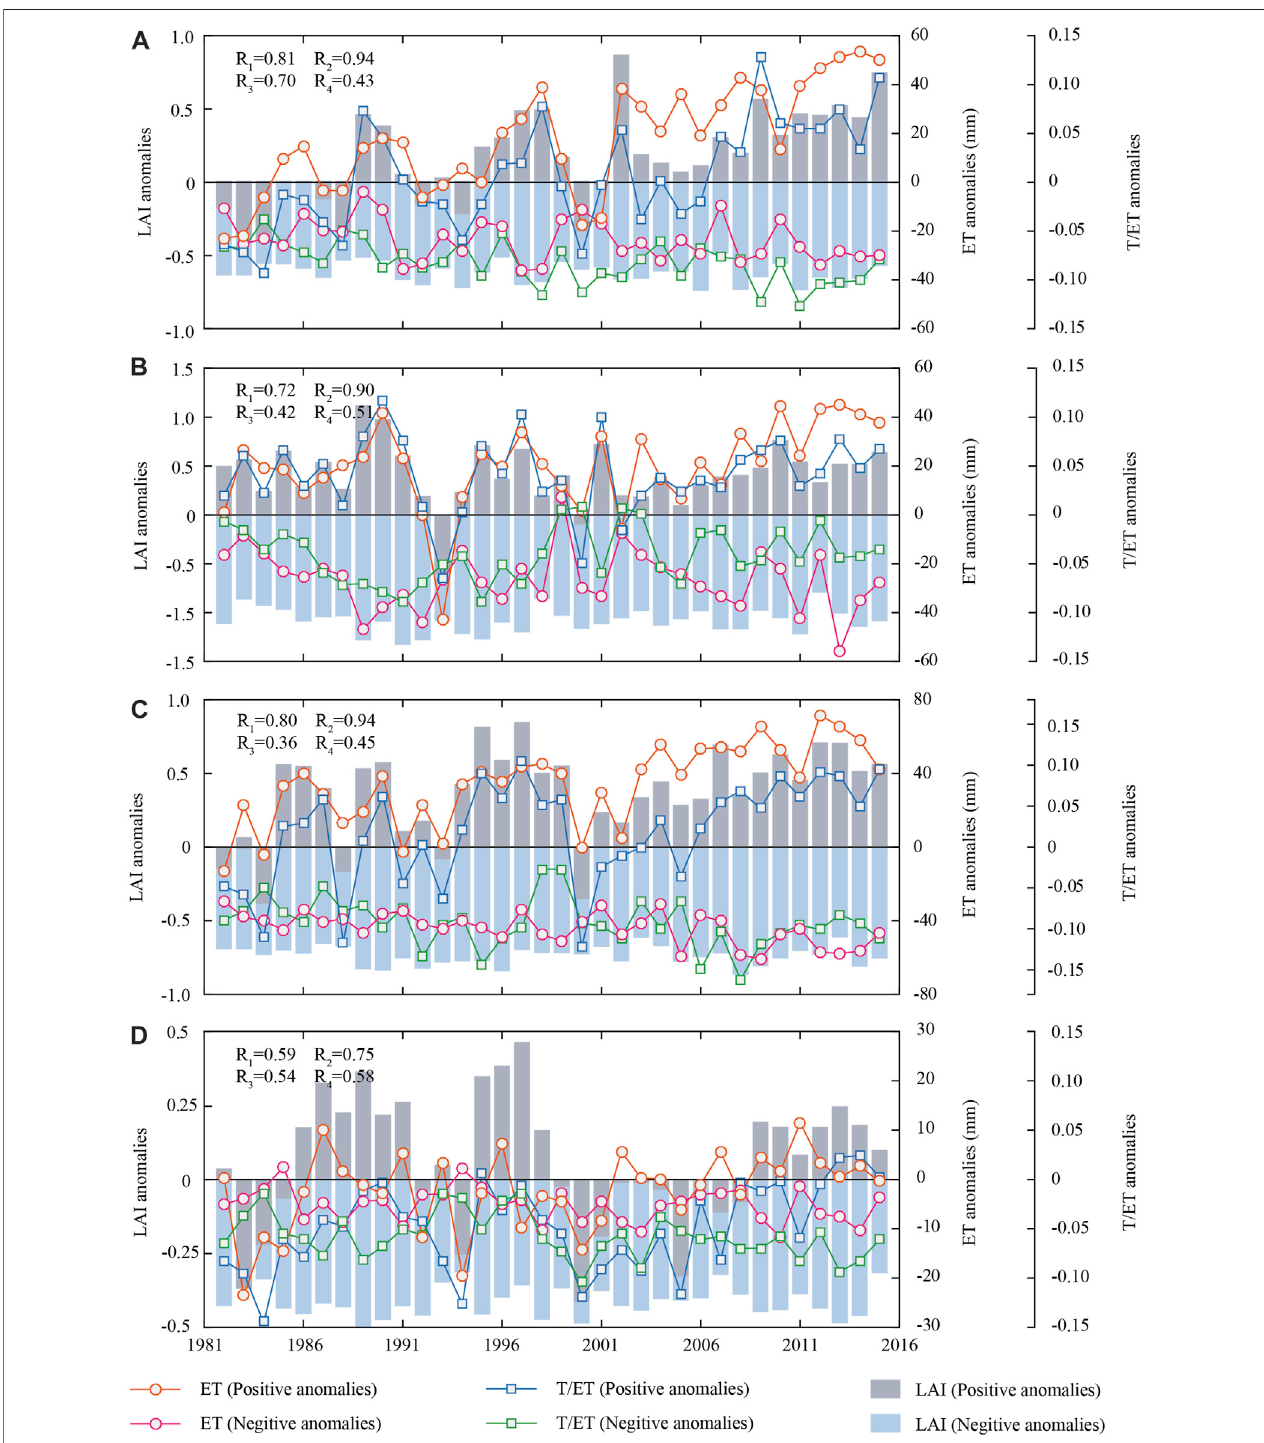
FIGURE 8 | Interannual anomalies of LAI, ET, and T/ET in four seasons. Where R 1 and R 2 represent the correlation coef fi cients of LAI with ET and T/ET when the vegetation is positive anomalies, respectively; R 3 and R 4 represent the correlation coef fi cients of LAI with ET and T/ET when the vegetation is negative anomalies, respectively. Spring (A) summer (B) autumn (C) and winter (D) .